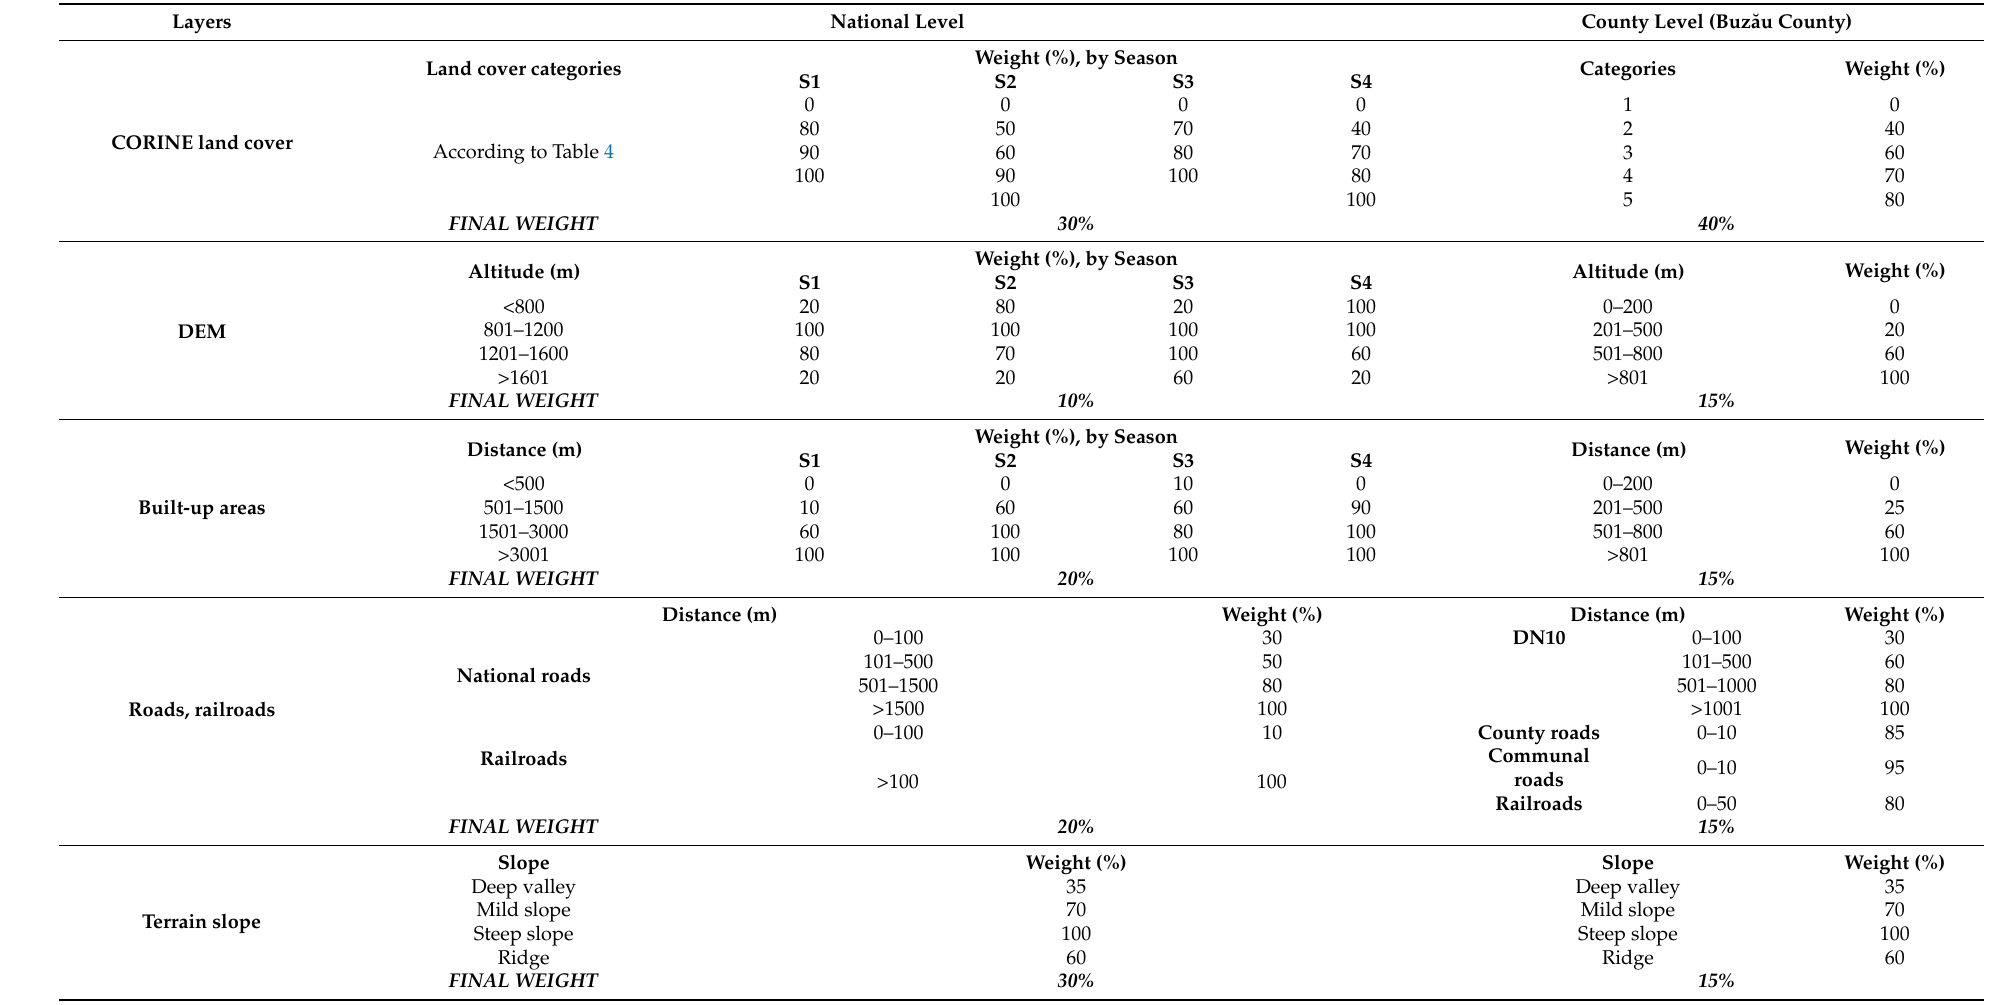
Table 3. Weights used for each habitat factor and each layer. The figure also presents the final weights obtained by choosing the weighted geometric mean (data processed after